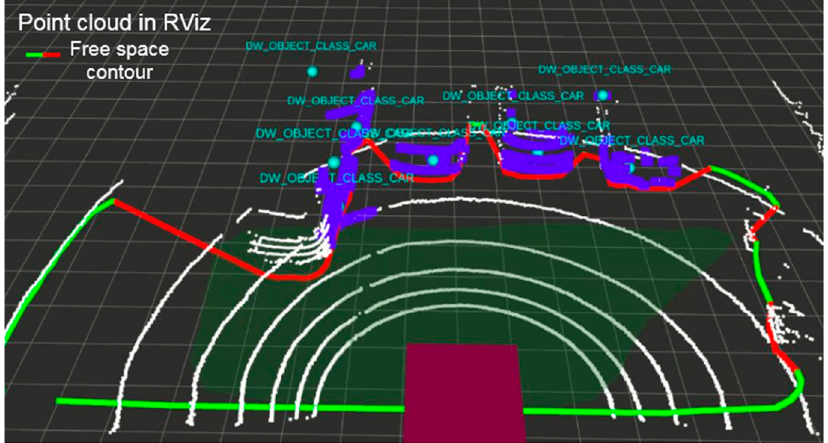
Figure 17. VLP-16 lidar point cloud visualization with contour of detected free space in front of the vehicle.